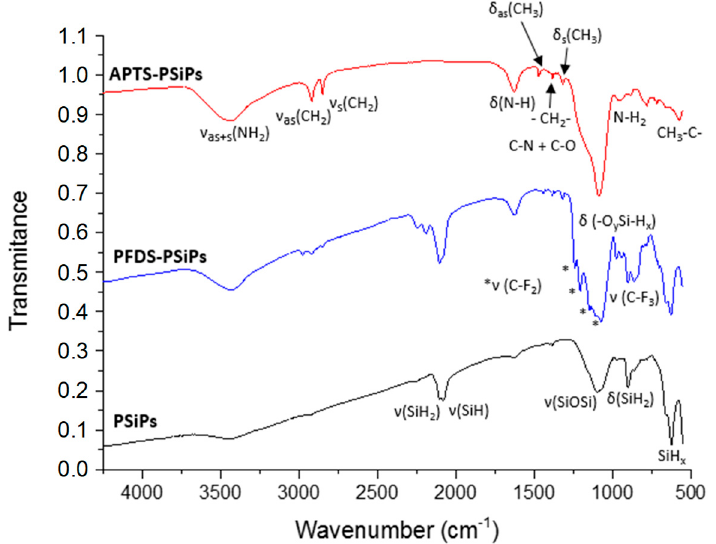
Figure 6. Fourier transformed infrared spectroscopy (FTIR) spectra of APTS and PFDS functionalized PSiPs compared with the spectrum corresponding to freshly formed PSiPs.